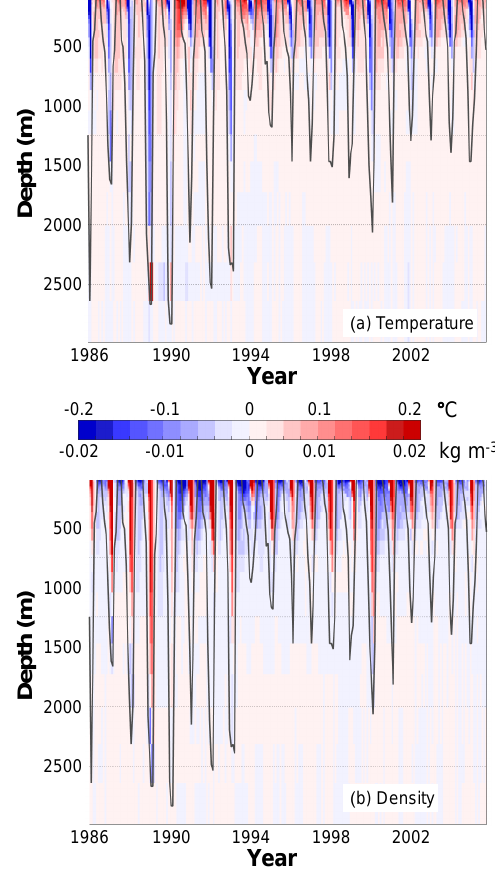
Figure 4. For only one model, CanESM2, Hovmöller diagram showing the difference from 1 month to the next of the tempera- ture (a) and density (b) profiles with depth in the subpolar gyre. Dark grey line represents the SG mixed layer depth. Black dotted vertical lines highlight the depth levels representative of NADW: 750, 1250, 2000 and 2500m.